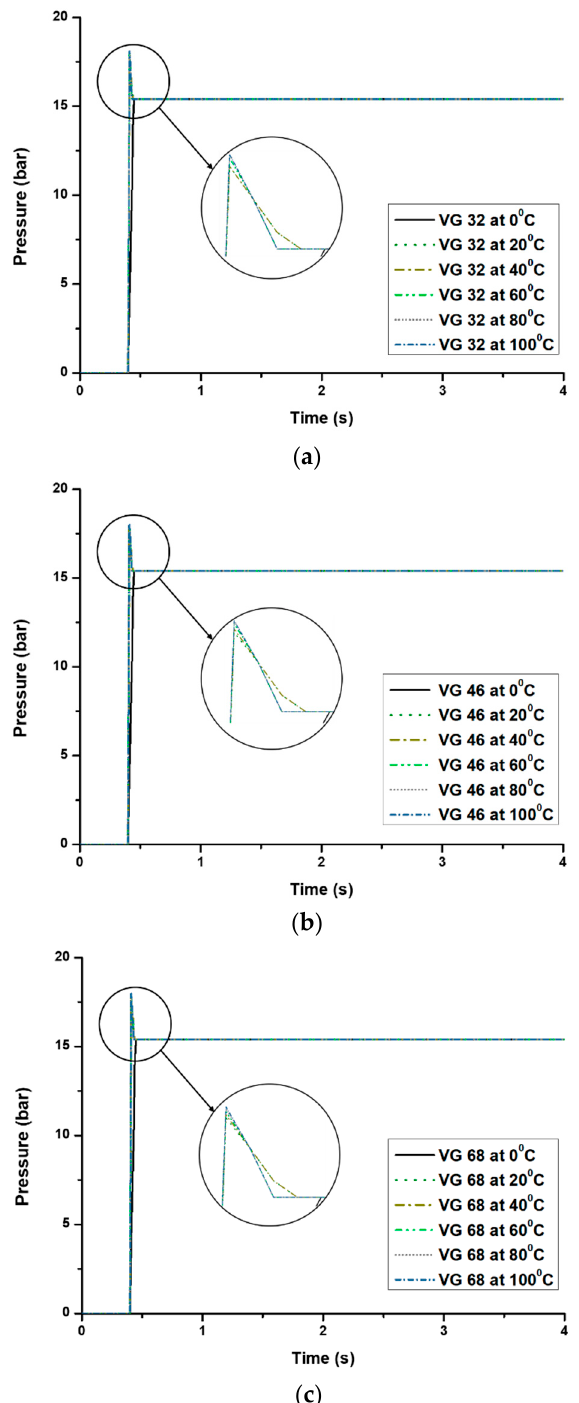
Figure 10. Performance of the control algorithm considering viscosity at various temperatures, namely: ( a ) Hydraulic oils VG 32, ( b ) VG 46, and ( c ) VG 68.